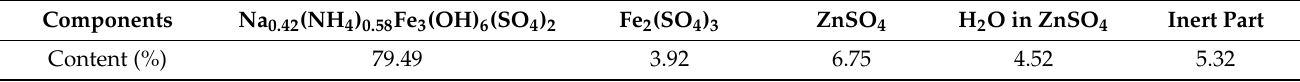
Table 4. Estimated constitution of jarosite residue sample